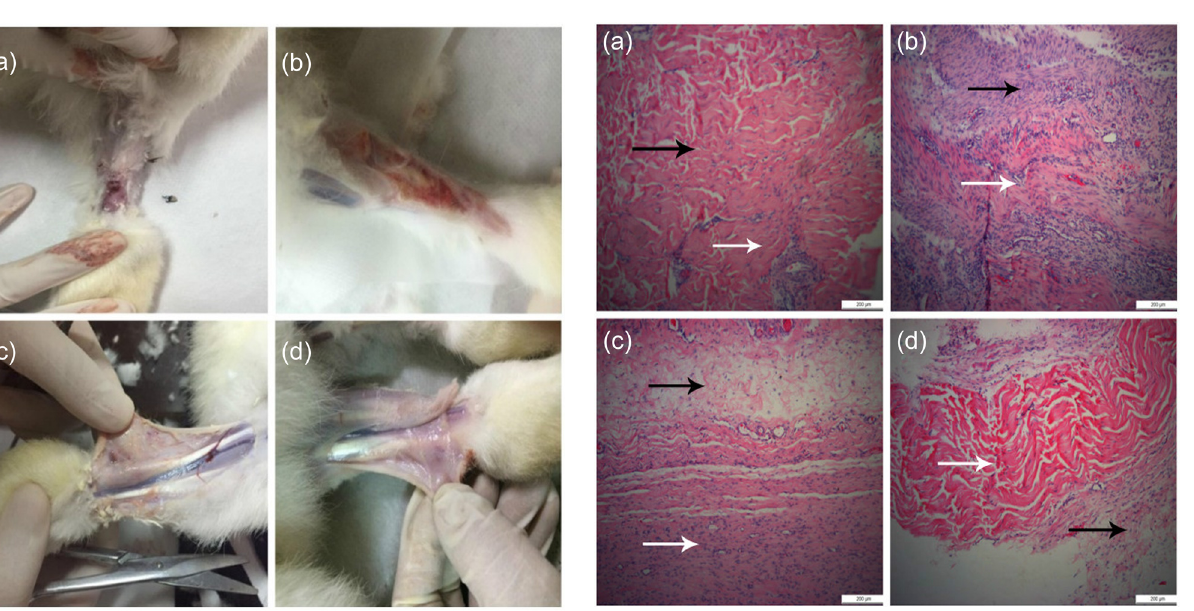
Figure 7: Adhesions associated with the Achilles tendon in rabbits: ( a ) Group 1 received normal saline; ( b ) Group 2 received injections of the bFGFp; ( c ) Group 3 received targeted microbubble ( the contrast agent with bFGFp and the target location factor, ICAM - 1 antibody ) ; and ( d ) Group 4 received microbubbles with bFGFp.